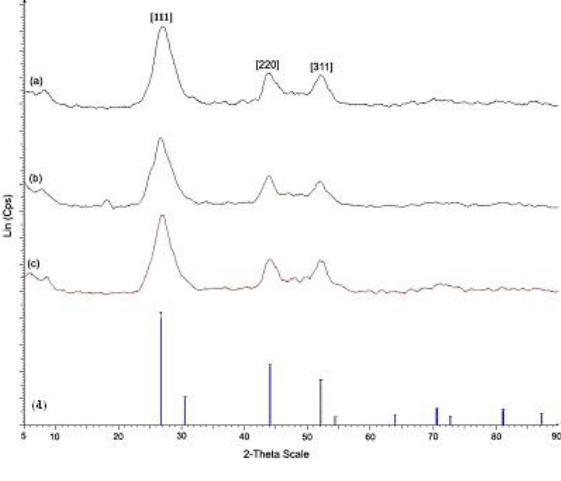
Figure 2. X-ray diffraction patterns of (a) CdS nanoparticles (b) CdS: Ia nanocomposites (1.0:1.0) (c) CdS: IIa nanocomposites (1.0:1.0) (d) cubic CdS (JCPDS